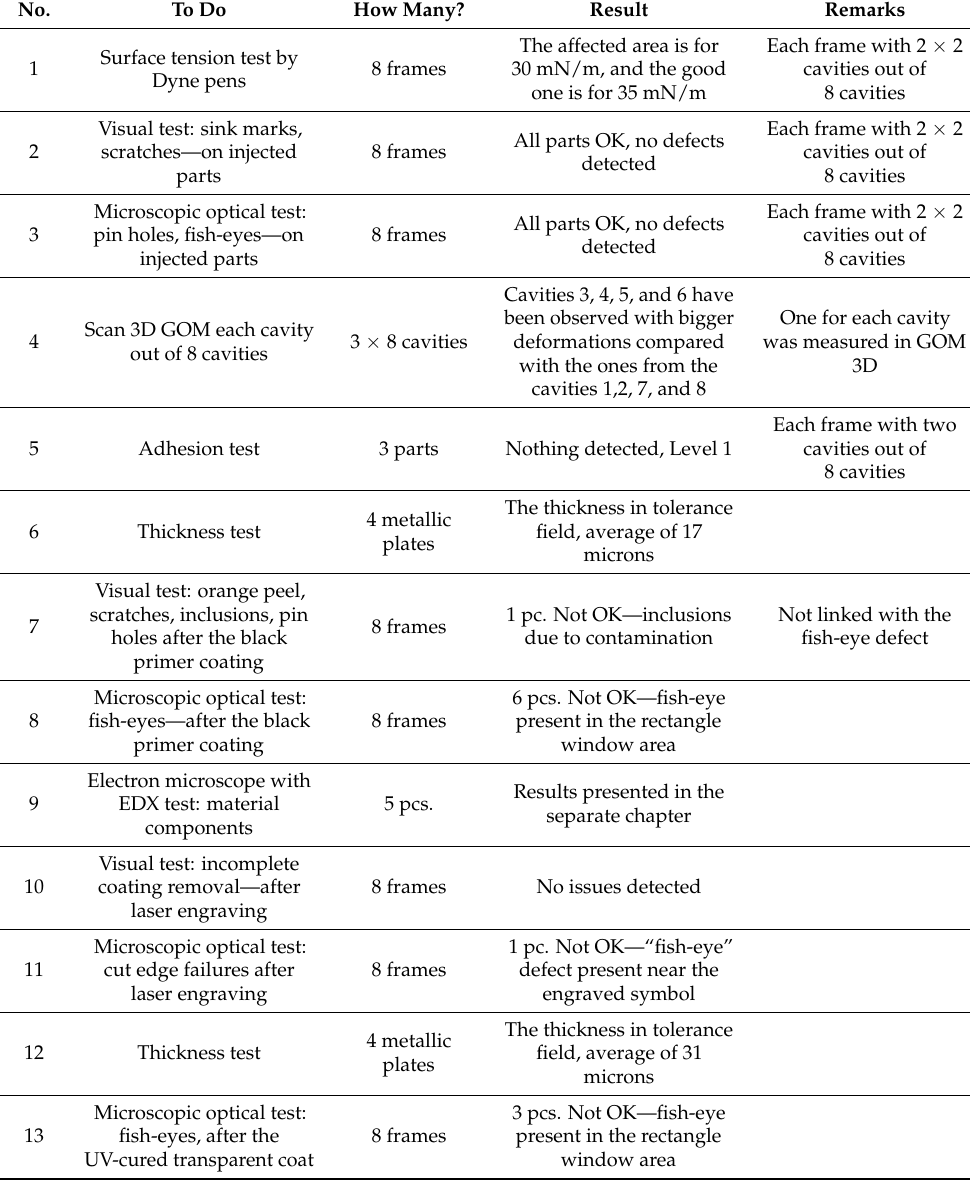
Table 2. The tests and the results.